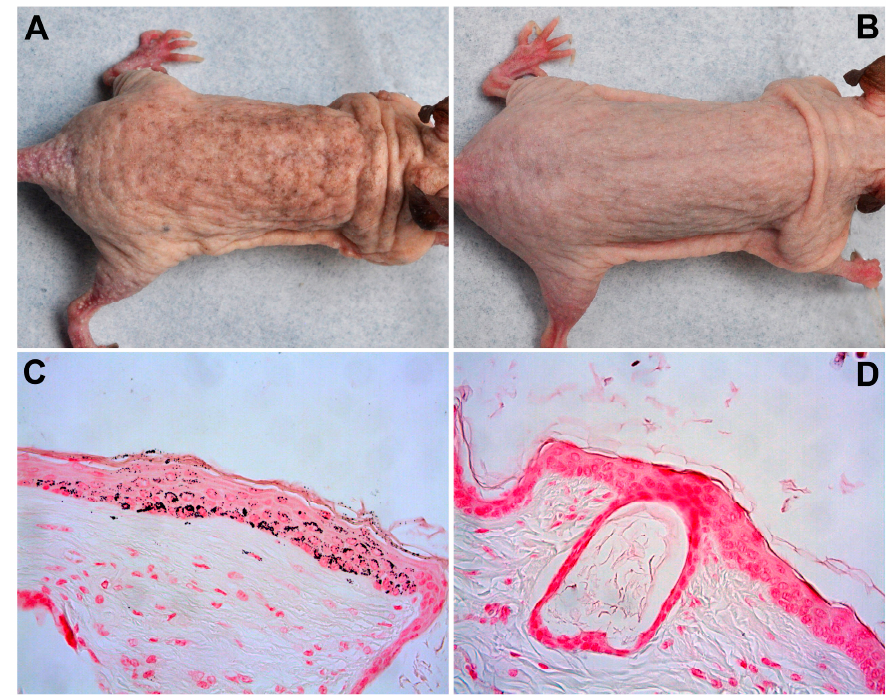
Figure 1. ( A ) Picture of a pigmented mouse; ( B ) Picture of a non-irradiated control mouse; ( C ) Melanin staining (Fontana-Masson ×40) of UV irradiated mouse skin [17]; ( D ) Melanin staining (Fontana-Masson ×40) of non-irradiated mouse skin with no visible melanin [17]. Figures 1C,D have been previously published [17], and are reproduced with permission from Catharina M. Lerche, Experimental Dermatology; published by Wiley and Sons, 2009.